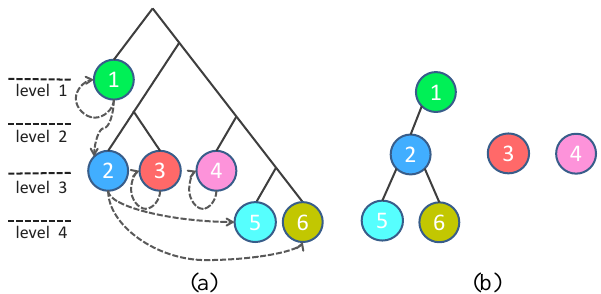
Figure 6. ( a ) The binary tree of a MSFA pattern and the demosaicing order; ( b ) the corresponding demosaicing forest.